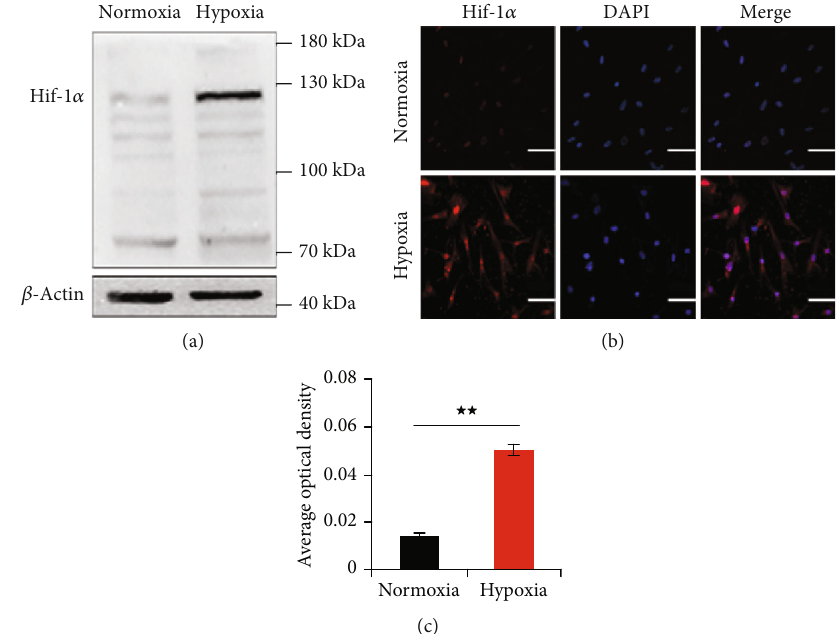
Figure 4: The expression of Hif-1 α at 7 days after hypoxic induction. Representative western blots (a) and immuno fl uorescence staining (b) of Hif-1 α (red) and DAPI-labeled nuclei (blue) and quanti fi cation data of immuno fl uorescence staining (c) under normoxia and hypoxia condition in BMSCs. Scale bar = 50 μ m; Magni fi cation: × 400. Data were shown as mean ± SD . ★ p < 0 : 05 ; ★★ p < 0 : 01 , vs. the normoxia